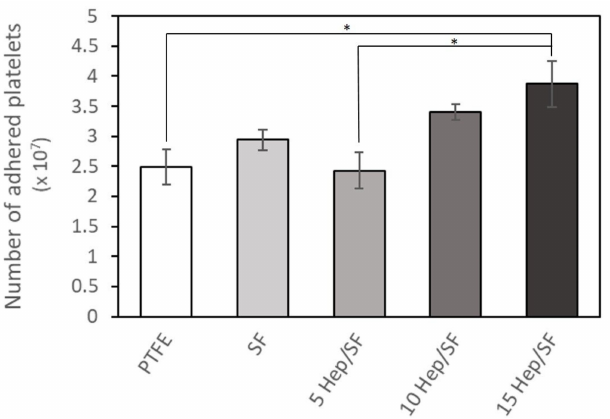
Figure 4. The number of adhered platelets on the samples after 1 h of incubation under diluted platelet concentrate and determined by LDH assay. * p < 0.05 between the groups.